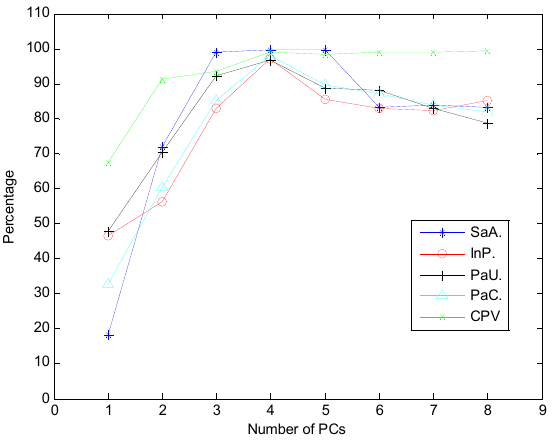
Figure 18. Clustering OA and CPV under a varying number of PCs on SalinasA, Indian Pines, Pavia Center and Pavia University data sets.